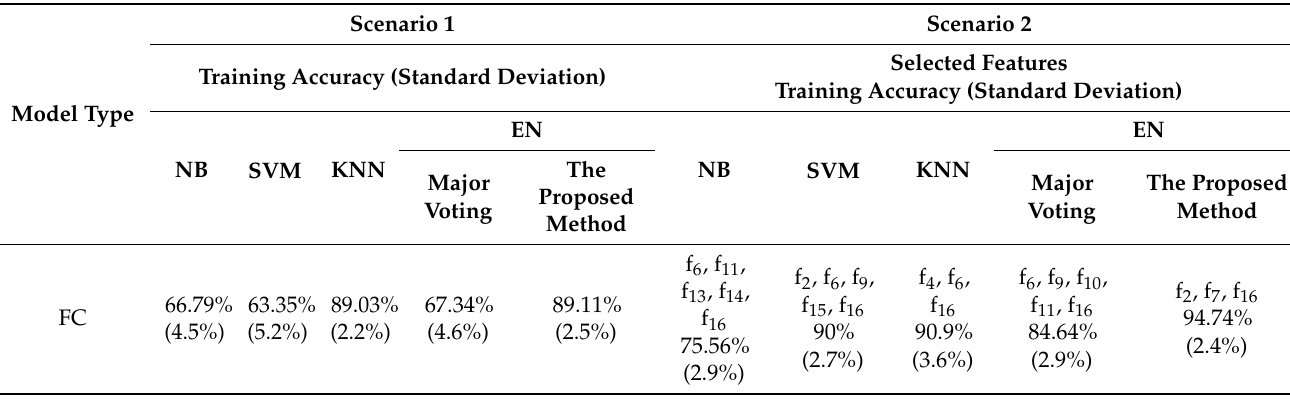
Table 8. The training results of the FC layer.